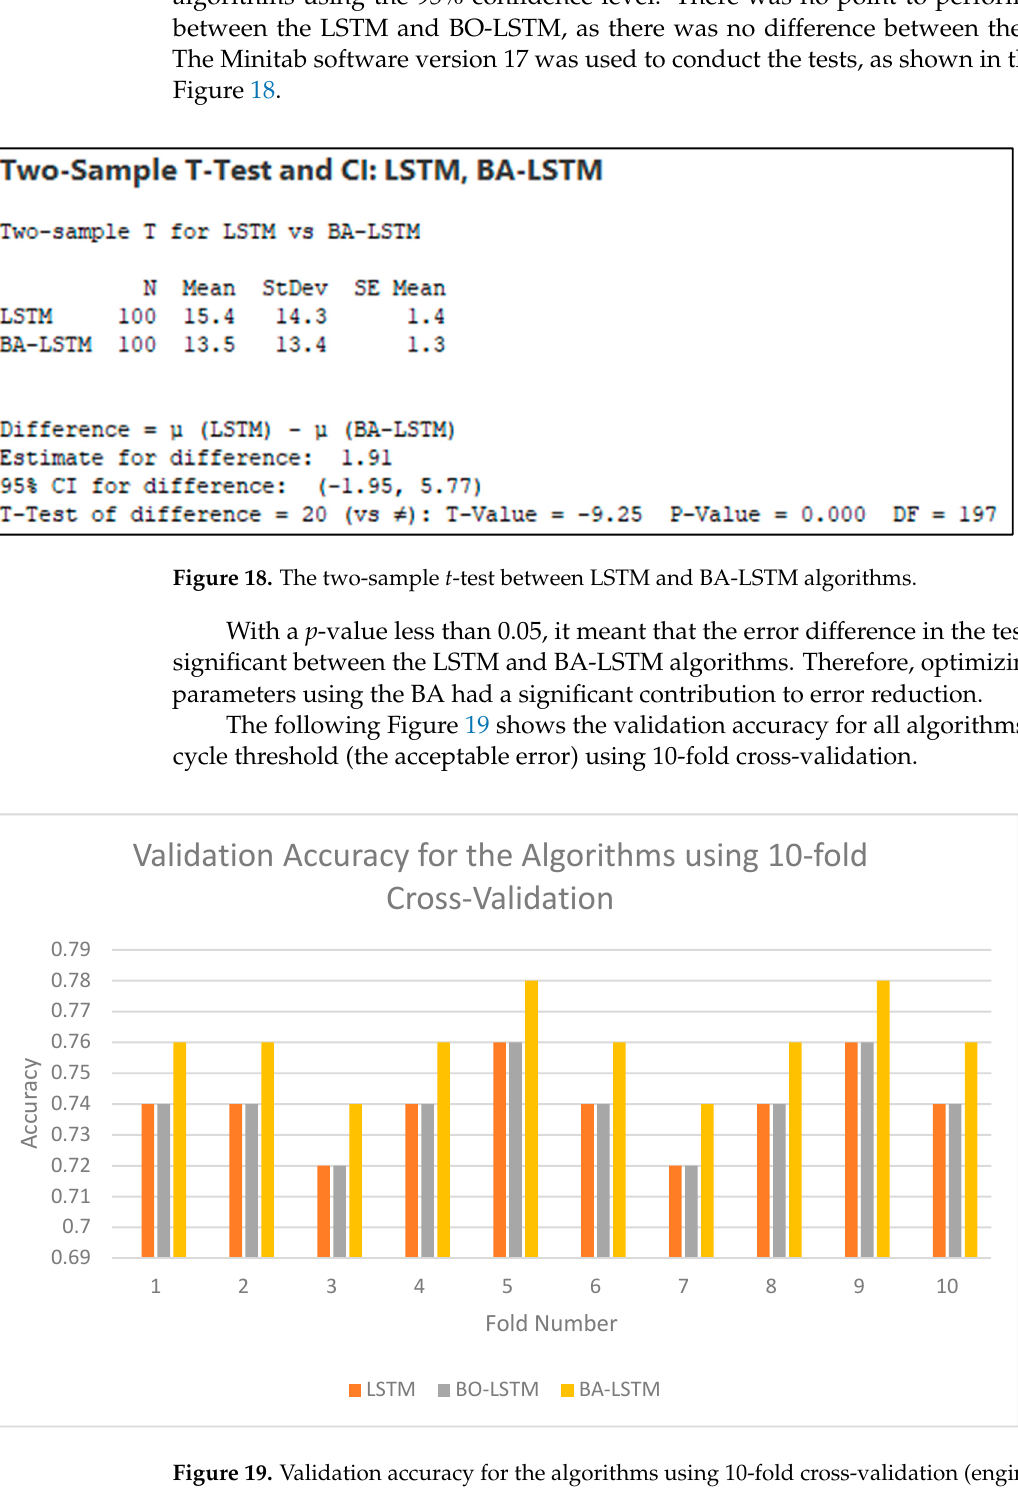
Figure 17. Training progress for the hybrid BA-LSTM algorithm (engine dataset).